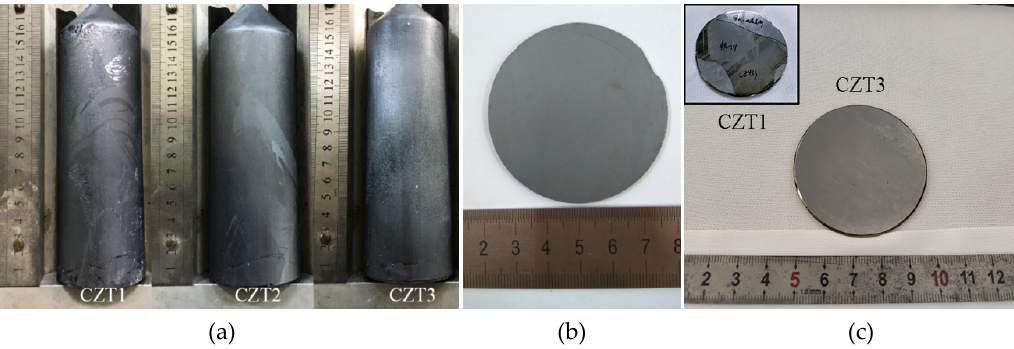
Figure 2. ( a )As-grown Cd 1-x Zn x Te (CZT) ingots, ( b ) single-crystalline wafer cut from ingot CZT3, and ( c ) wafer etched with the Everson solution; the major shows the wafer cut from CZT3, and the inset shows the wafer cut from CZT1.